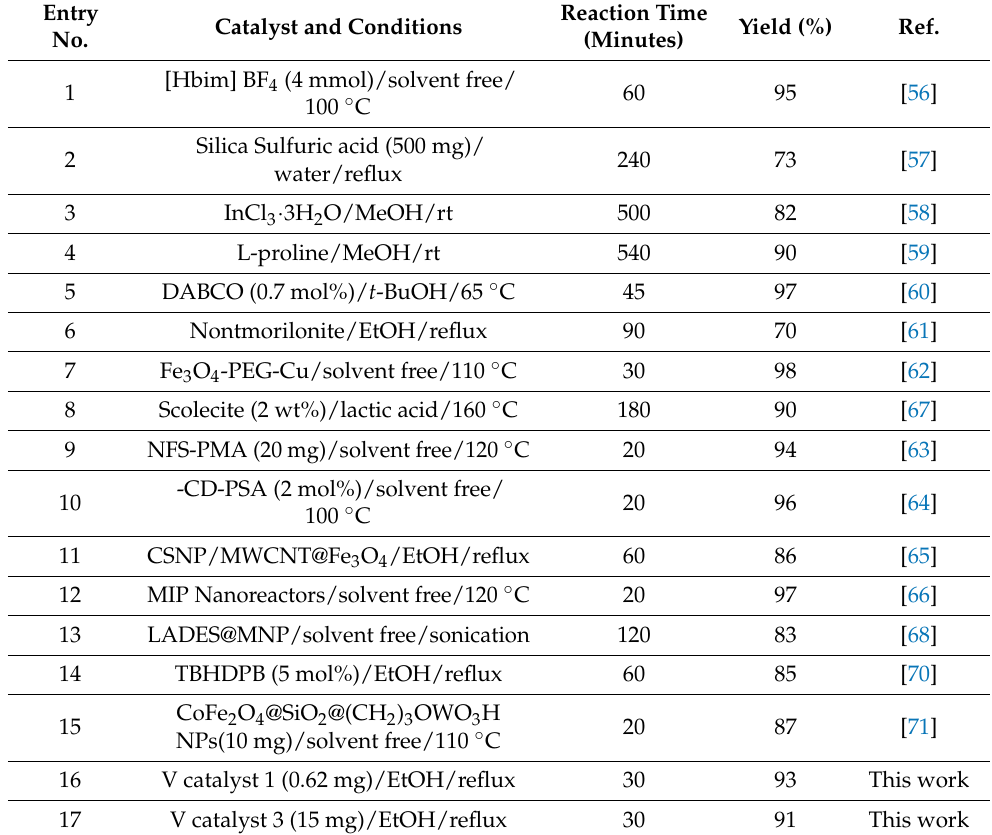
Table 5. Comparison of the Results for the Synthesis of 2,4,5-Triphenyl-1 H -Imidazole Derivatives using Different